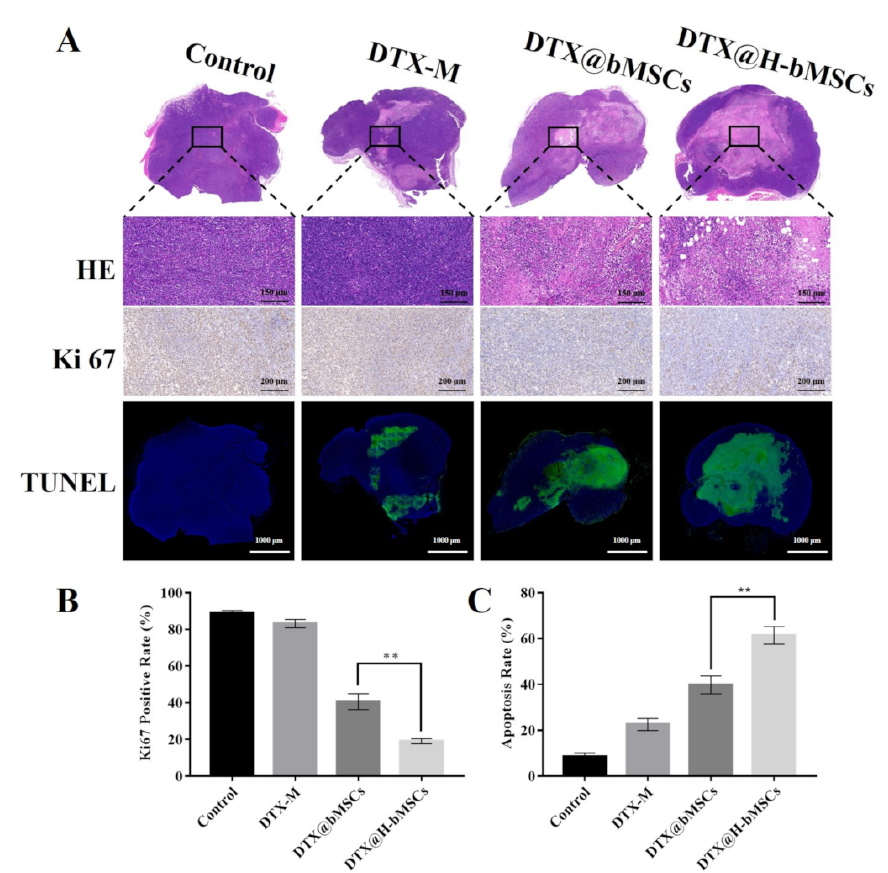
Figure 9. Histopathological analysis of tumor tissues after administration. The histopathological section including HE stain, Ki 67 stain, and TUNEL stain in each group ( A – C ) indicate quantification of Ki 67 and TUNEL stain, respectively. (** p < 0.01) (values are mean ± SEM, and there were five samples in each group.).